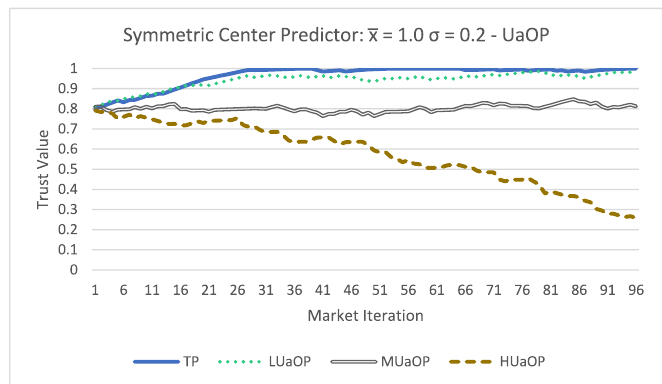
Figure 6. Symmetric Low Predictor.